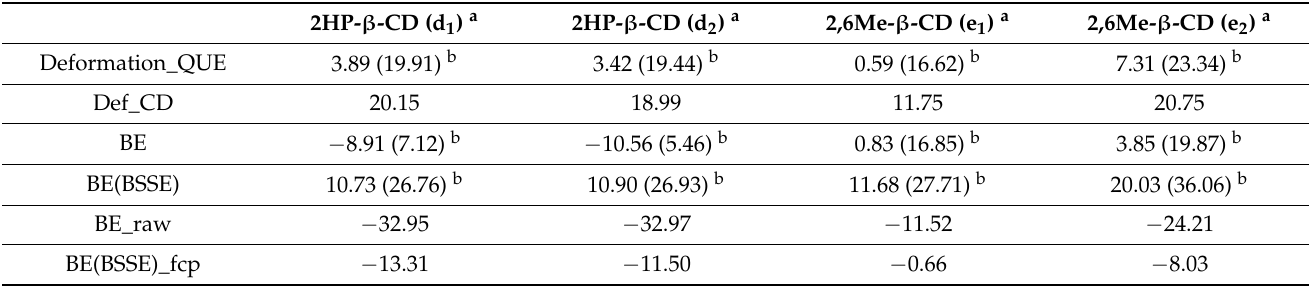
Figure 7. Conformations of the QUE complexed with 2HP- β -CD ( a ) and 2,6Me- β -CD ( b ). Hydrogen bonds are shown with dashed lines. Table 8. Binding energies, BE, corrected values for BSSE, BEBSSE, and binding energies with respect to the deformed structures of the molecules of the complex, BEr (kcal/mol), deformation energies of the QUE and cyclodextrin, DefL and DefCD., at B3LYP/6-31G(d,p). All energies are expressed in